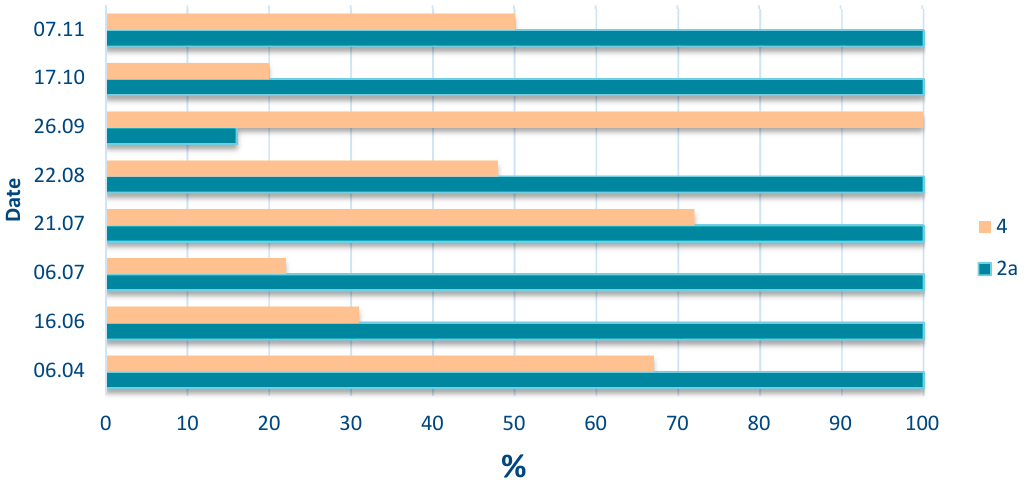
Figure 9. Reduction of coliform cells in the final point 4 of SED-BIO in relation to the sedimentation segment (point 2a). The results are shown as a percentage.